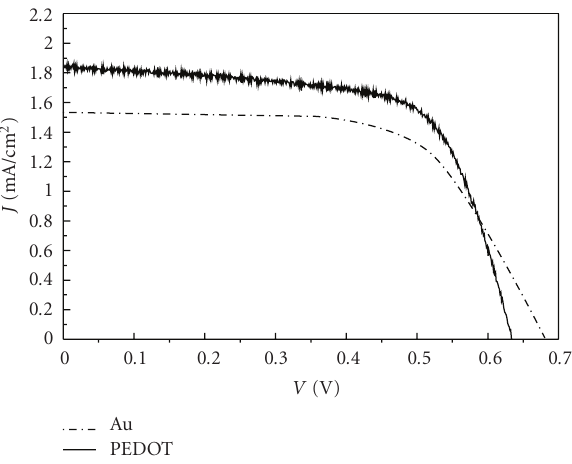
Figure 23: J-V curves of Co(II)/(III)-mediated cell employing a gold (dashed line) and a PEDOT counter electrode (solid line). Electrolyte composition is 0.15 M Co(II)/0.5M Li + /0.1 M Tbpy in acetonitrile. Cell is equipped with a 120 μ m spacer. Photosensitizer